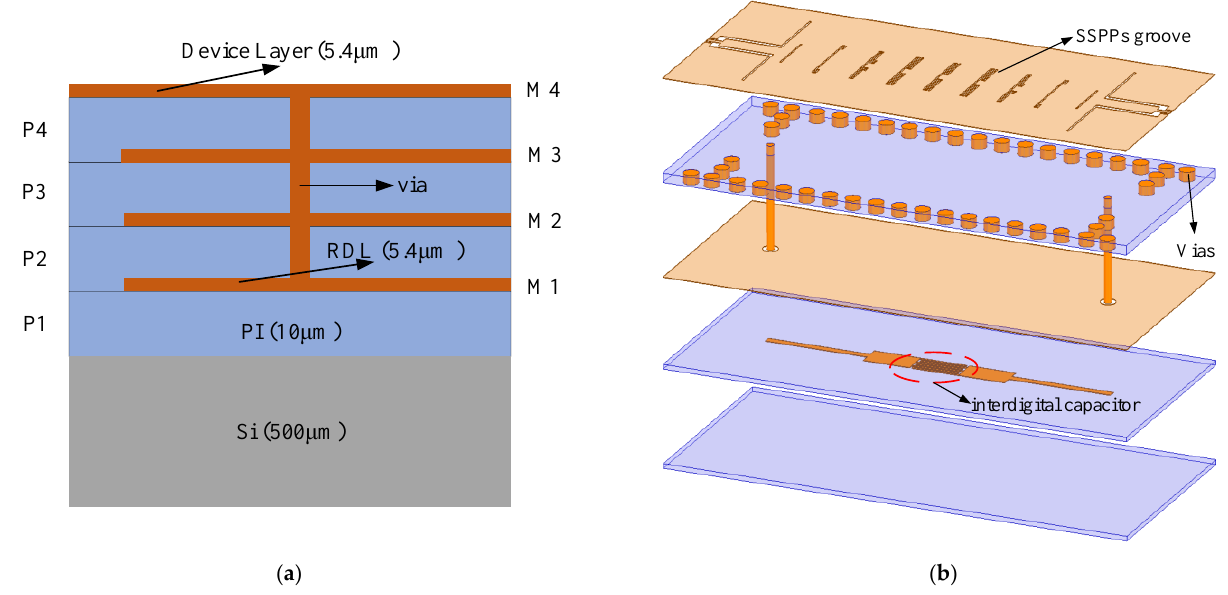
Figure 2. Vertical view of the proposed SIW BPF based on SSPP.